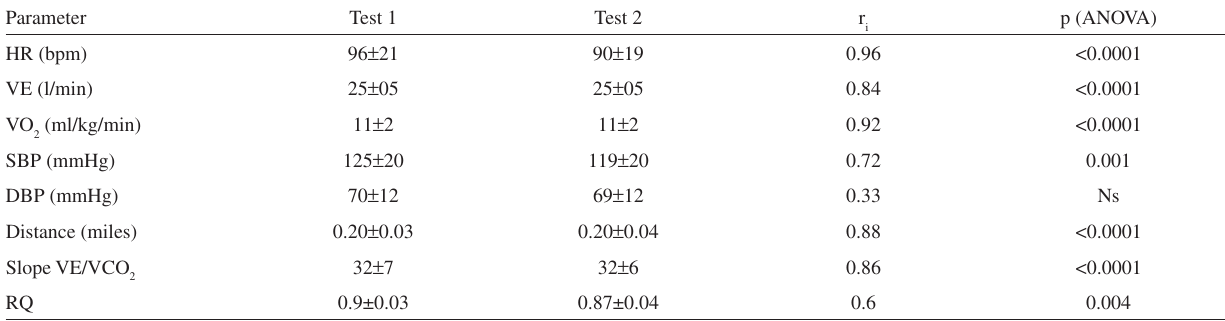
Table 2 - Intraclass Correlations Coefficients (ri) for six-minute cardiopulmonary walking test-related parameters Parameter Test 1